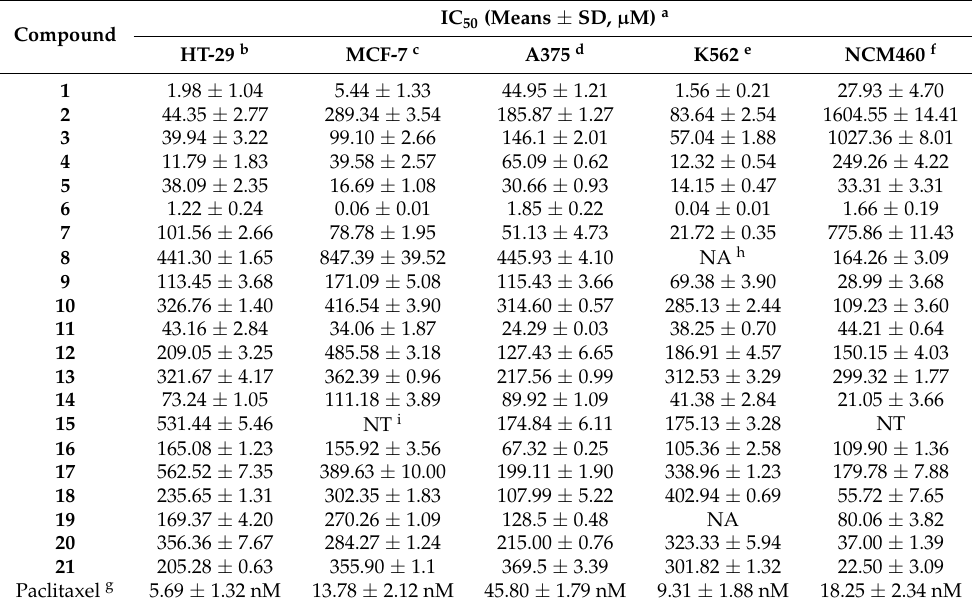
IC 50 (Means ± SD, µ M) a